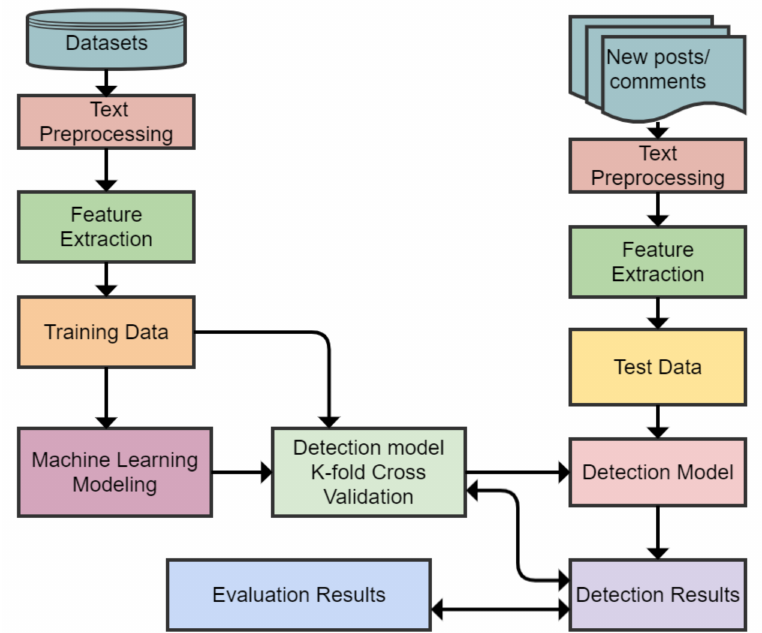
Figure 1. Hate speech detection